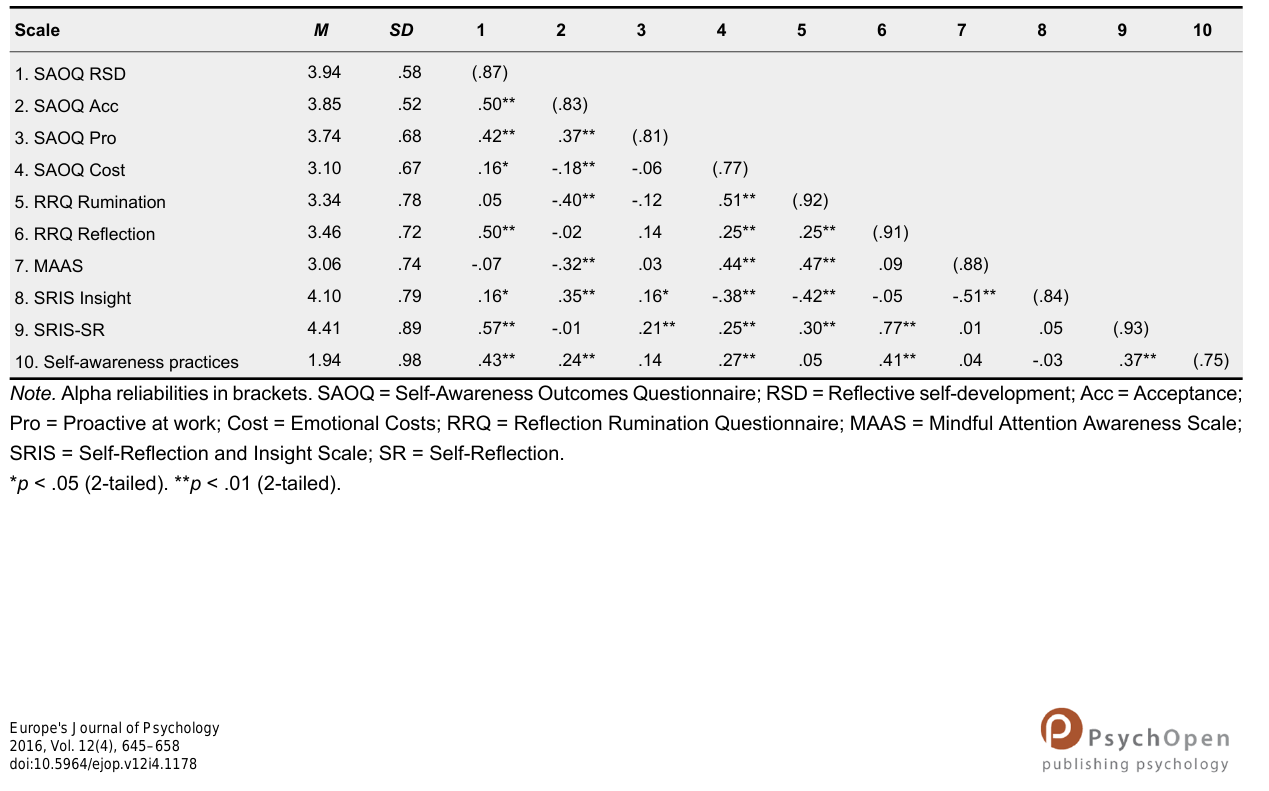
Descriptive Statistics and Correlations for all